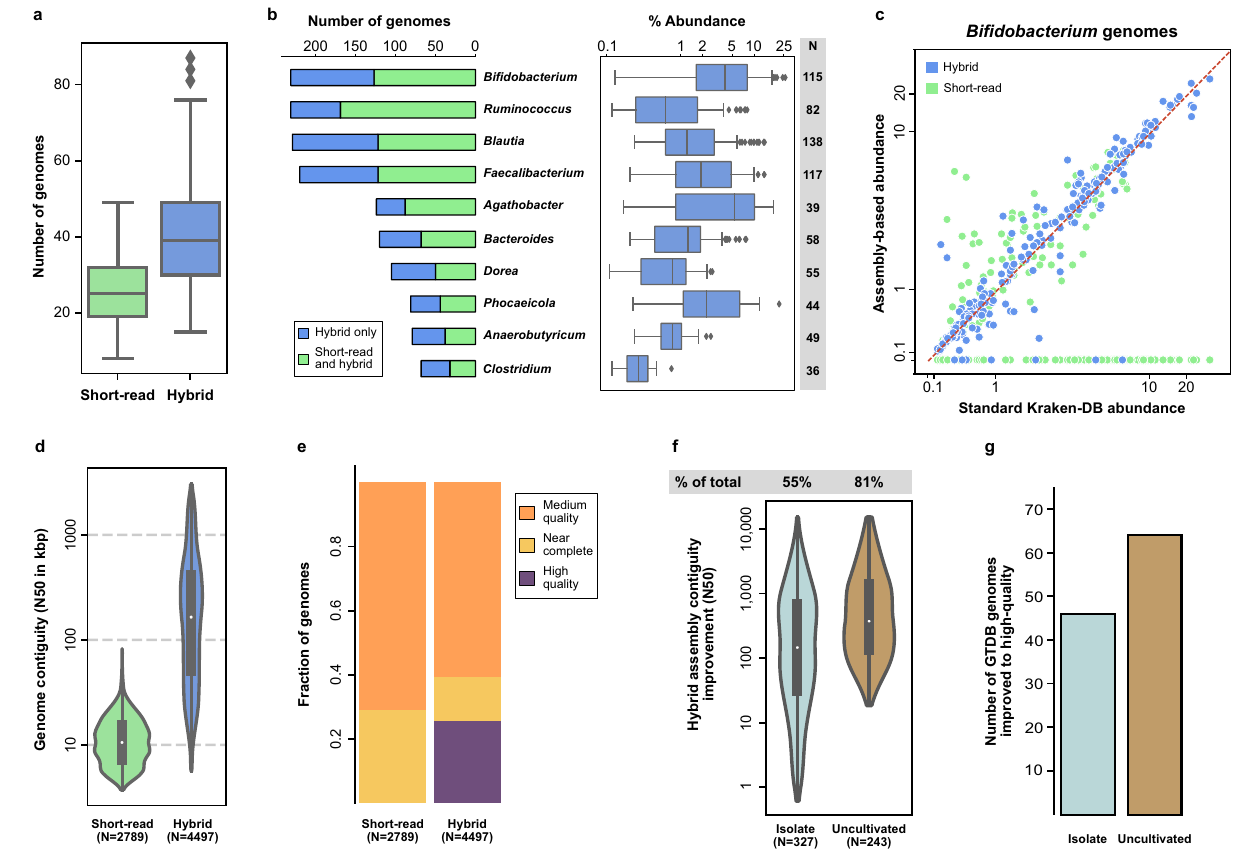
Fig. 1 | Assembly strategy for high-quality microbiome references. a Boxplots showing the number of MAGs obtained across metagenomic datasets using short-read and hybrid assemblies ( n =109). b Stacked barchart showing genus- speci fi c breakdown of the number of MAGs obtained using short-read and hybrid assemblies (left) and boxplots for corresponding relative abundances of thegenera(right).Nrepresentsthe numberofhybridonlyMAGsforeachgenus. c Scatter-plot showing the relative abundance of Bi fi dobacterium genomes estimated using short-read or hybrid assemblies for a sample ( y -axis) versus corresponding relative abundances obtained using the standard Kraken2 data- base ( x -axis). Points found along the x -axis represent Bi fi dobacterium species found using the Kraken standard database but not found using either short-read or hybrid MAGs. d Violin plots showing the distribution of a contiguity metric